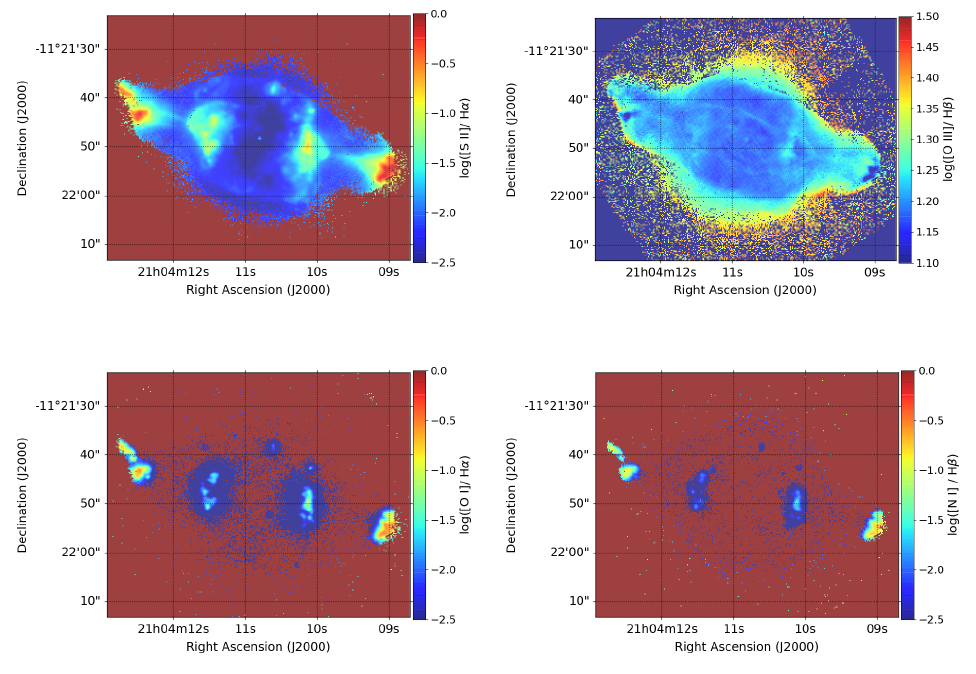
Figure 3. Emission line ratio maps of NGC 7009: [S II ] λ 6716 + λ 6731/H α ( upper left panel ), [O III ] λ 4959 + λ 5007/H β ( upper right panel ), [O I ] λ 6300/H α ( lower left panel ), and [N I ] λ 5200/H β ( lower right panel